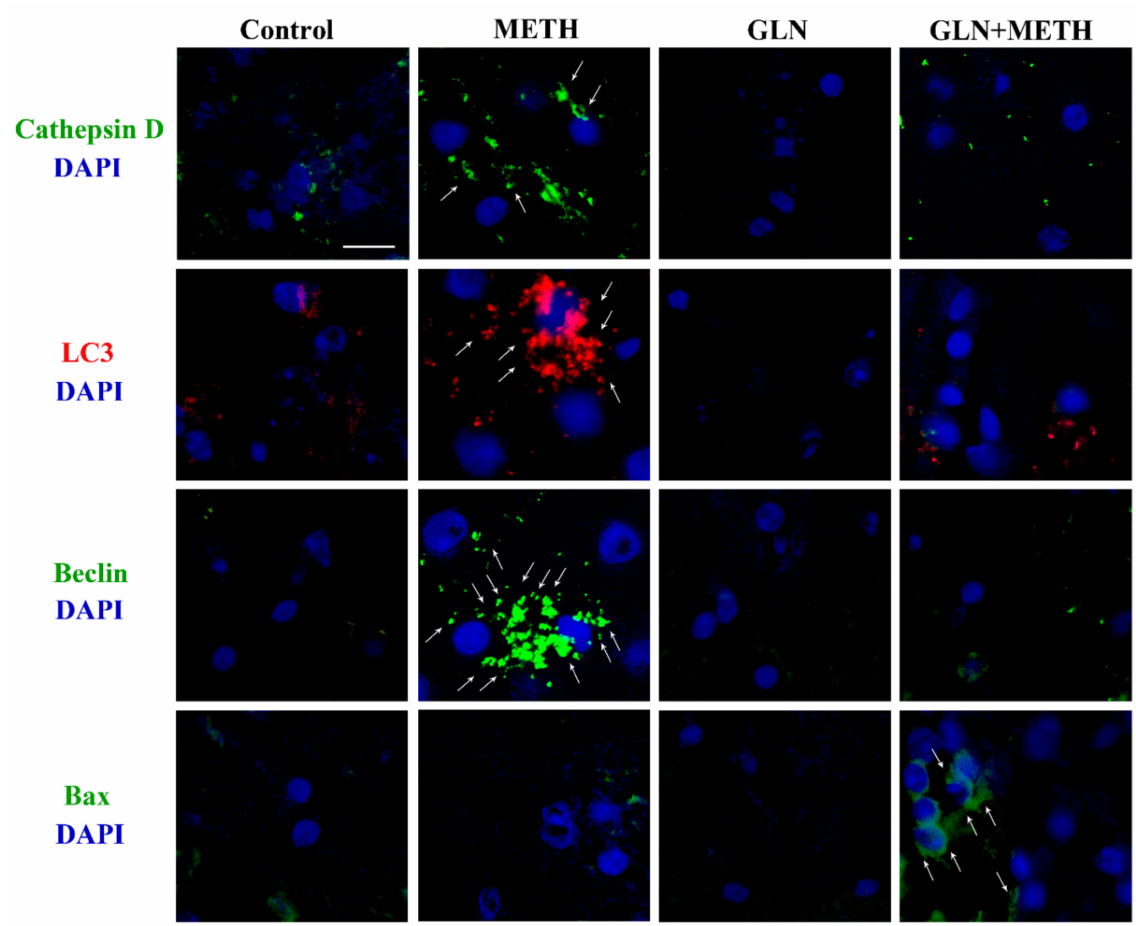
Figure 2. GLN impairs autophagy and worsens METH toxicity. Representative pictures from midbrain tegmentum showing immunofluorescence for the very same autophagy-related proteins LC3II, Beclin1 and Cathepsin-D and the apoptosis-related antigen Bax shown in Figure 1, in mice treated with saline (Control), METH, GLN and combined METH and GLN. Arrows indicate each specific antigen. Scale bar = 25 µ